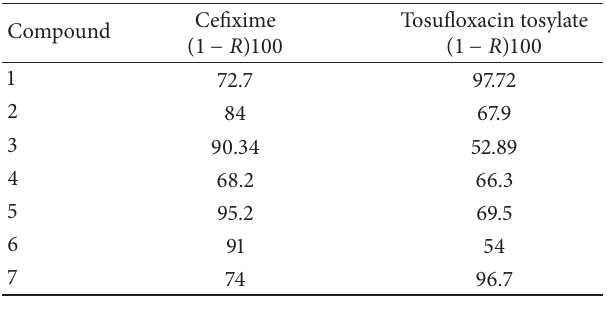
Table 5: Observed and predicted antibacterial activity of synthe- sized benzamide substituted Mannich bases against Escherichia coli